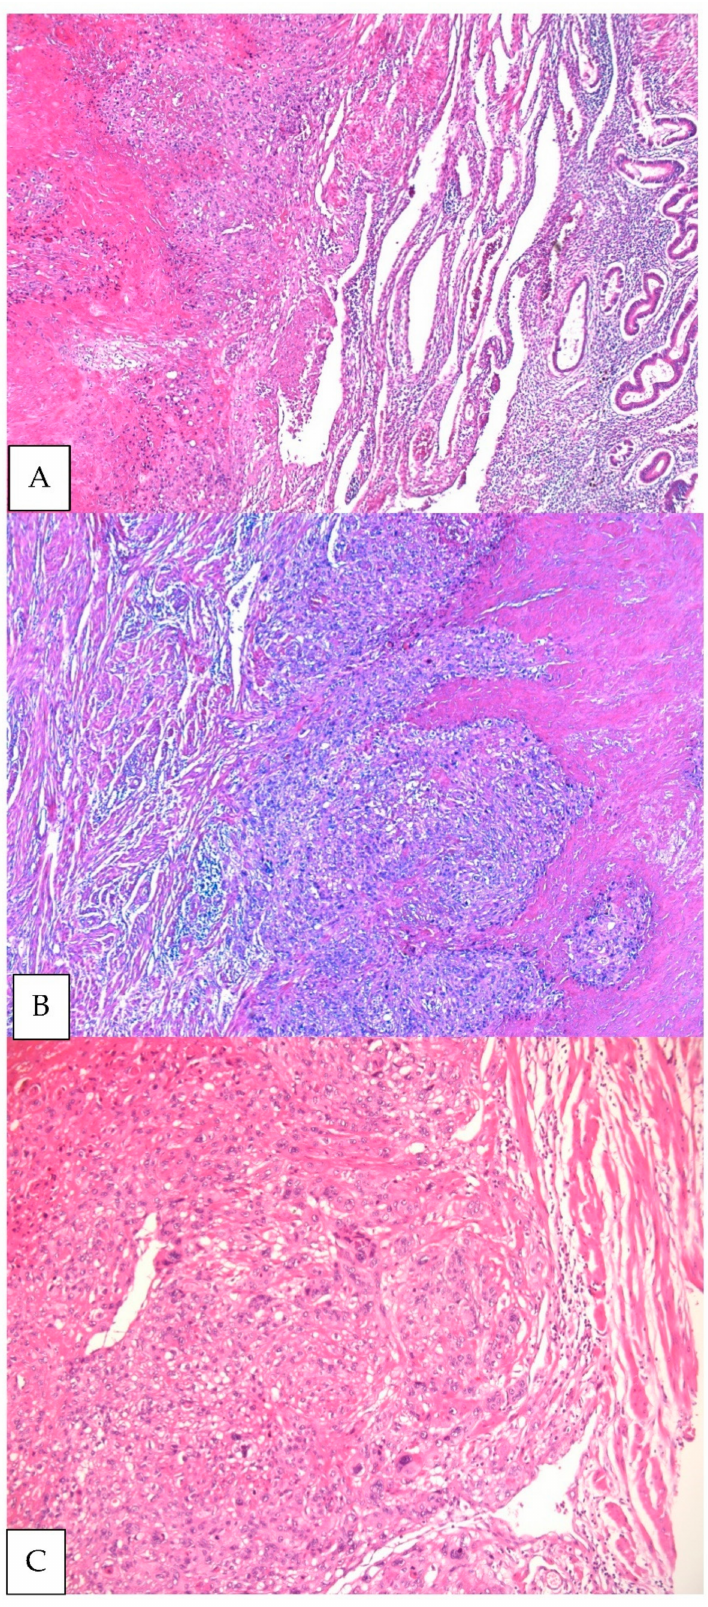
Figure 3. Histological analysis: hematoxylin-eosin stain; ( A ) tumor infiltration of the endometrial mucosa (magnification × 5); ( B ) pushing border and tumor necrosis (magnification × 5) ( C ) cellular atypia and tumor cells lining the blood vessel (magnification ×